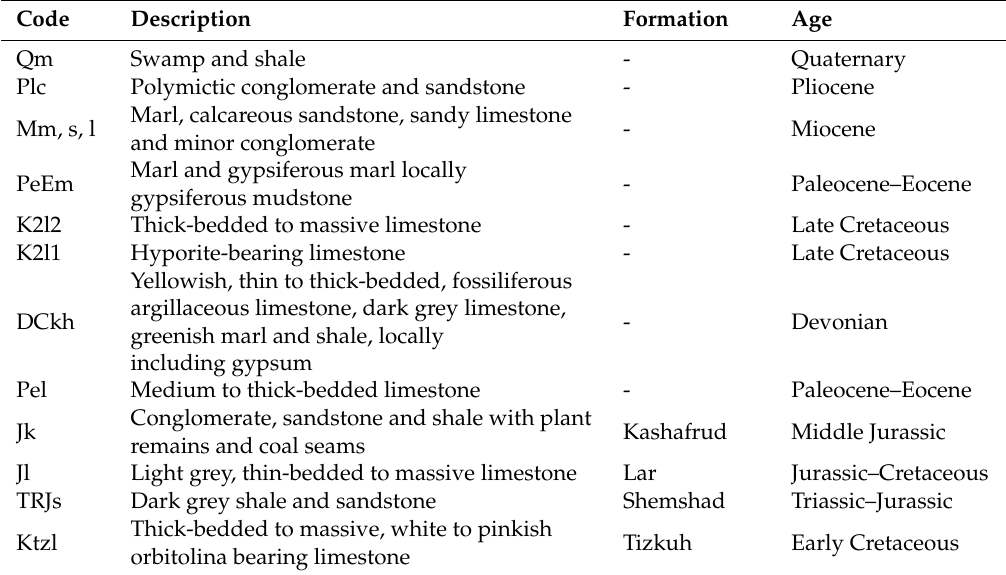
Table 1. Lithology of the study area